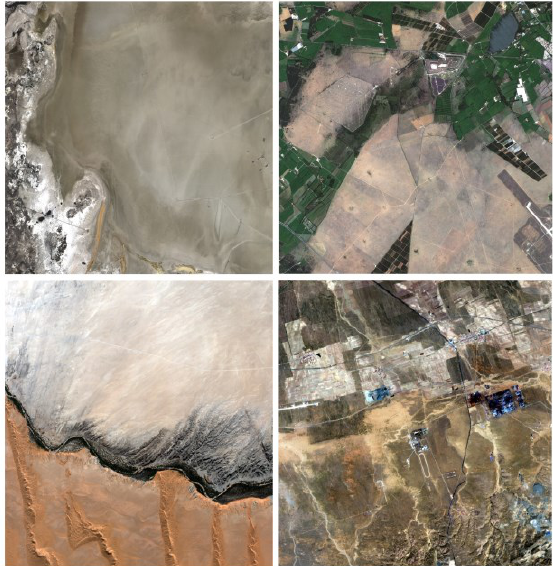
Figure 2. RadCalNet sites monitored by SSOT: Railroad Valley (UL), La Crau (UR), Gobabeb (LL) and Baotou (LR).